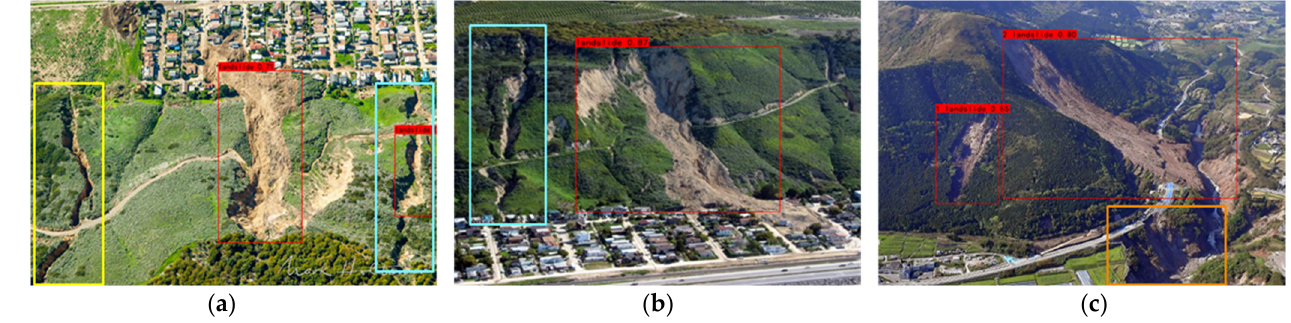
Figure 16. ( a ): The yellow box is the landslide fissure, and the blue box is the landslide detected after converting the angle; ( b ): the blue box is the missed landslide; ( c ): the orange box is the missed landslide.